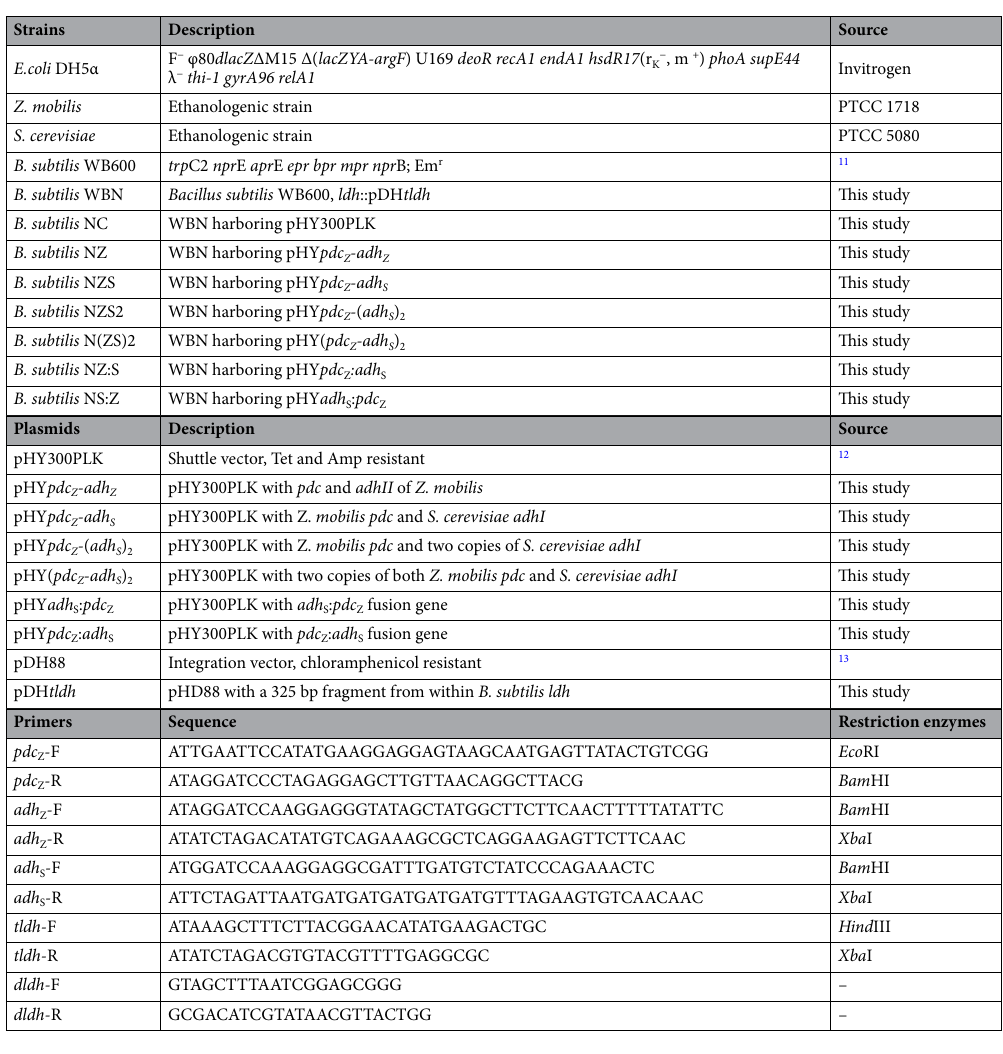
Table 1. list of strains, plasmids, and primers used in this